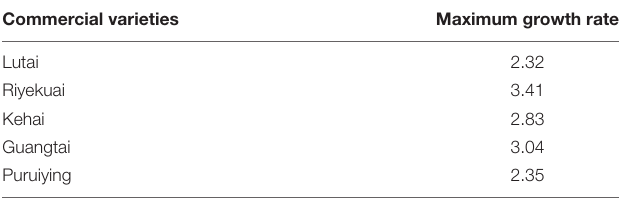
TABLE 4 | The maximum growth rate of the five L. vannamei commercial varieties. Commercial varieties